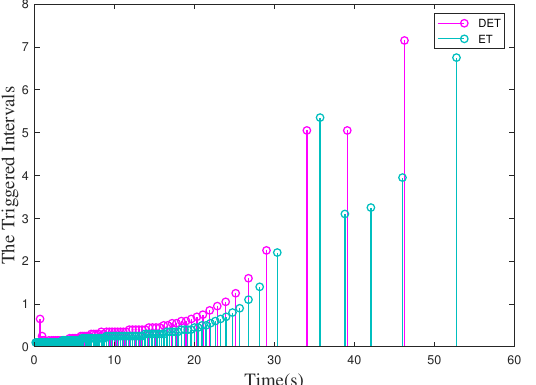
Figure 6. The triggered intervals of control systems without aperiodic DoS